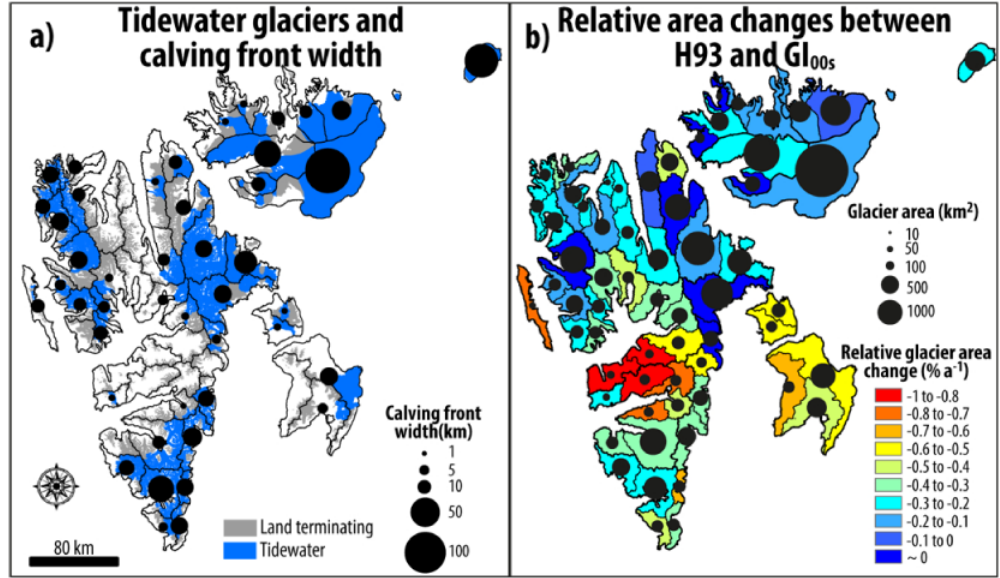
Fig. 6. (a) Distribution of land-terminating and tidewater glaciers in Svalbard. The sum of tidewater glacier front widths within each sec- ondary drainage basin is shown as size (area)-proportional circles. (b) Relative glacier area changes between H93 and GI 00s for each sec- ondary drainage basin, with total glacier area shown as size (area) proportional